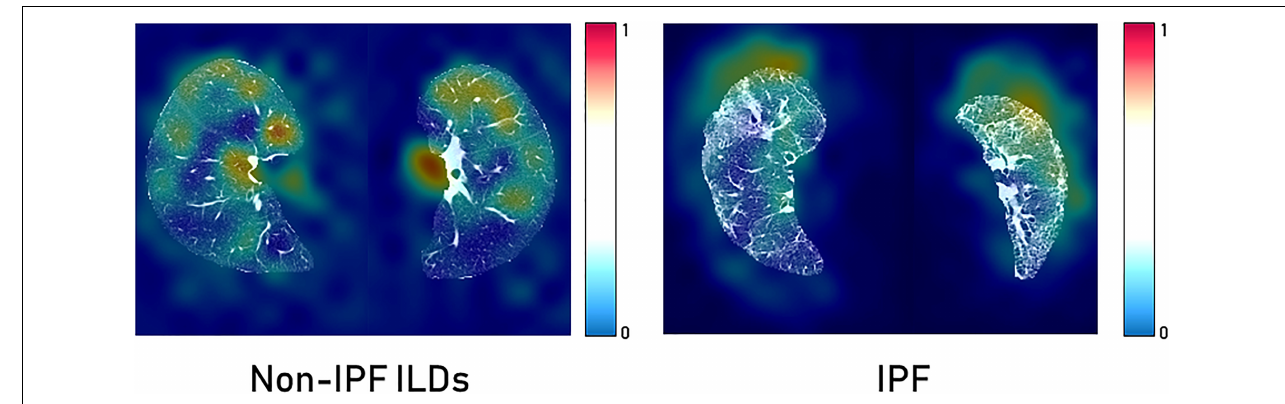
FIGURE 6 | GradCAM heatmaps for post-hoc interpretability of IPF and non-IPF ILDs HRCT scans to understand the predictions made by the